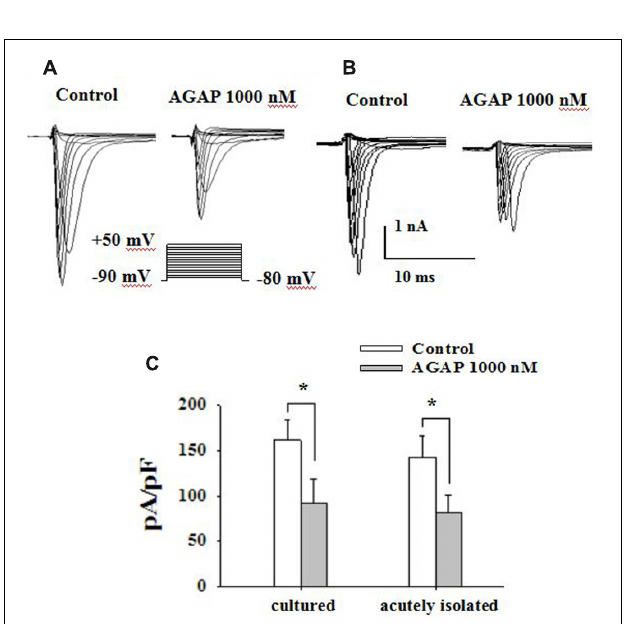
FIGURE 5 | AGAP inhibits voltage-gated sodium current in primary cultured and acutely isolated small-diameter neurons of rat. (A,B) Following the blockade of calcium and potassium channels, depolarizing voltage commands from − 80 to + 50 mV from a holding potential of − 90 mV elicited fast inward currents. The inward current responses were significantly reduced after the application of AGAP (1000 nM) in cultured and acutely isolated small-diameter DRG neurons. (C) The percentage inhibition for I Na was 46.9 ± 8.7 and 41.1 ± 6.2% in cultured and acutely isolated small-diameter DRG neurons, respectively ( ∗ p < 0.05, P values are from unpaired t -test, n = 15 and n = 19,